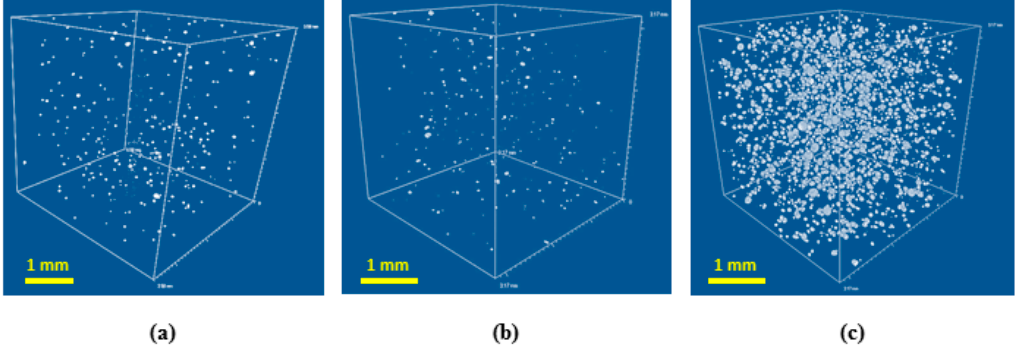
Figure 4. µCT image of closed pores included into foam volume for: ( a ) cPCL-2k-110, volume fraction of closed cells ≈ 0.05%; ( b ) cPCL-2/4/8k-180, volume fraction of closed cells ≈ 0.04%; and ( c ) cPCL-4k-220, volume fraction of closed cells ≈ 1.7%.